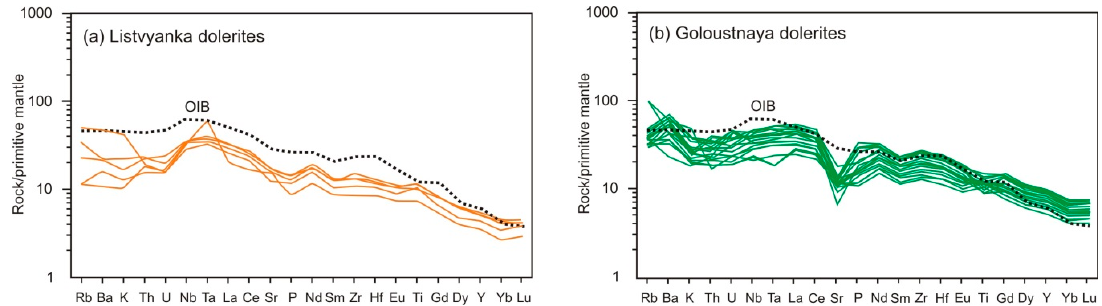
Figure 7. Primitive mantle ‐ normalized [36] multi ‐ element diagrams for Listvyanka ( a ) and Goloustnaya ( b ) dolerites. The OIB pattern is after Sun and McDonough [36]. ( b ) dolerites. The OIB pattern is after Sun and McDonough [36].